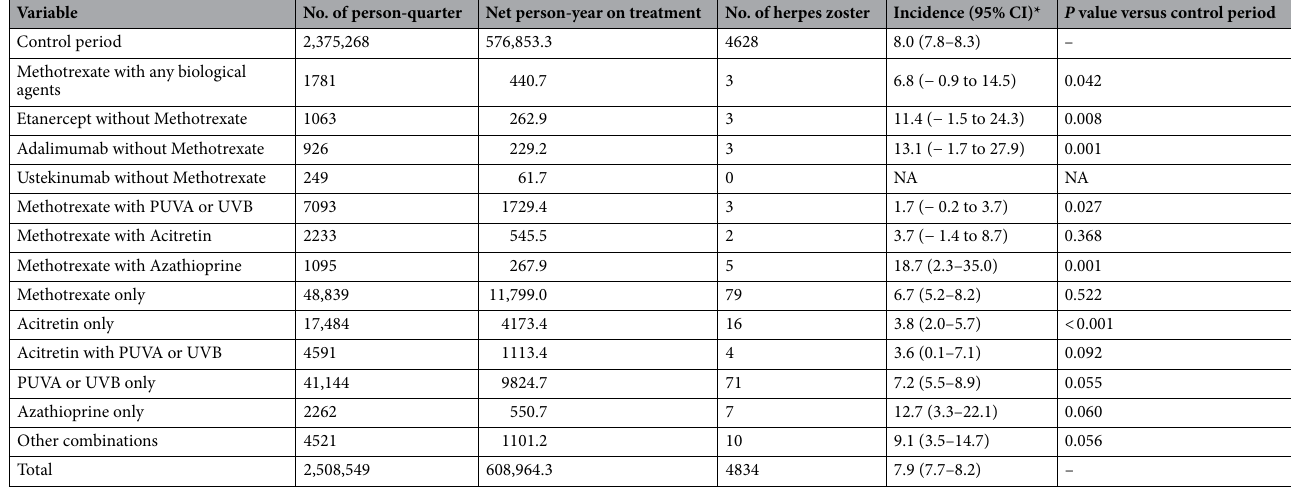
Table 2. Crude incidence of herpes zoster per 1000 person-years for each treatment. NA not applicable, PUVA photochemotherapy, UVB ultraviolet B. *Per 1000